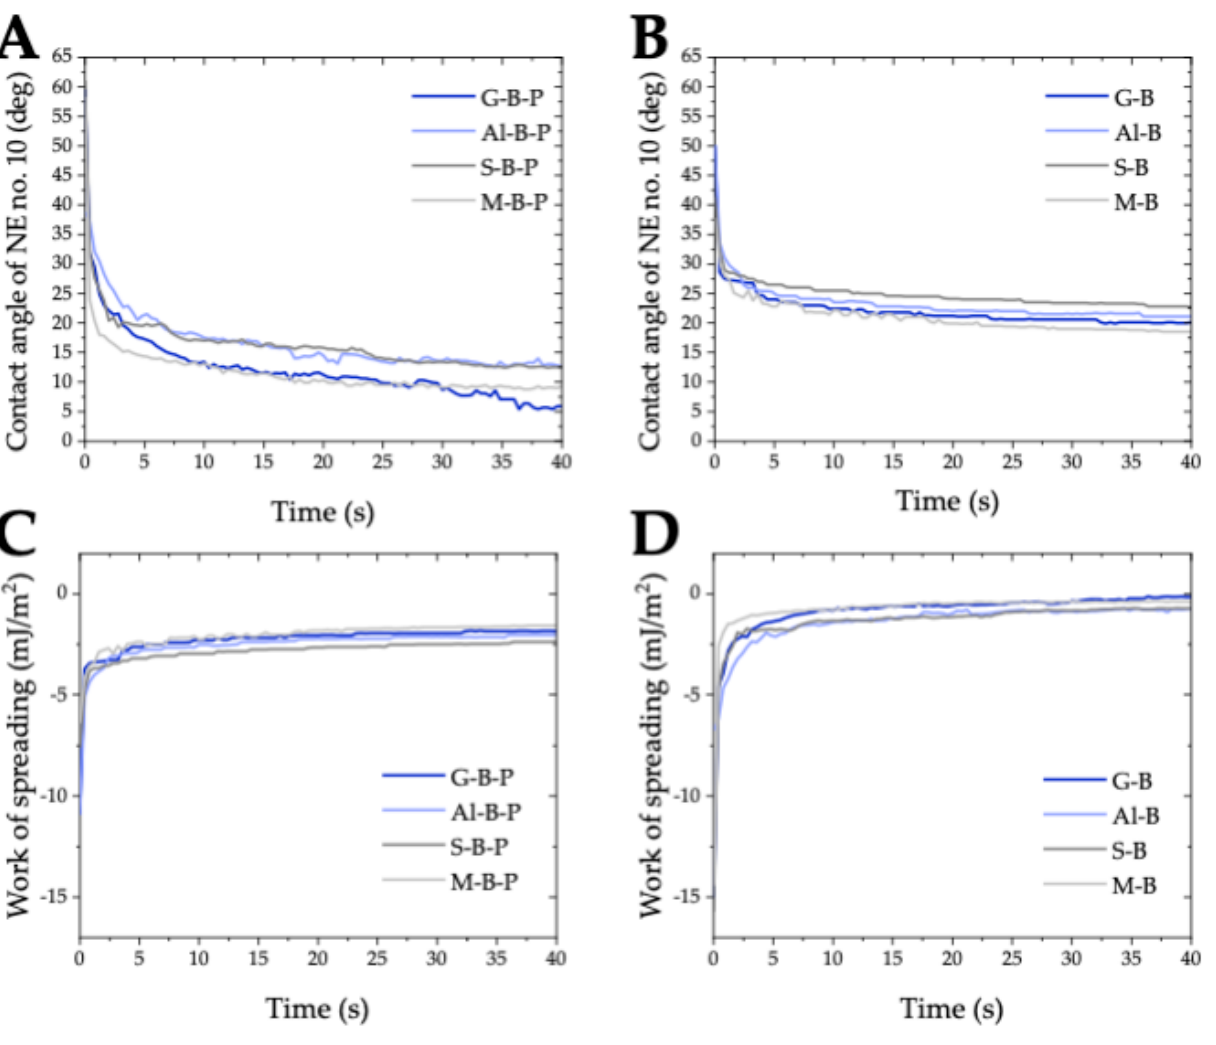
Figure 9. Dynamic contact angles of nanoemulsion No. 10 versus the time contact with the paint covered ( A ) and bare sensitive surfaces ( B ) and its work of spreading on the paint covered ( C ) and bare sensitive surfaces ( D ).